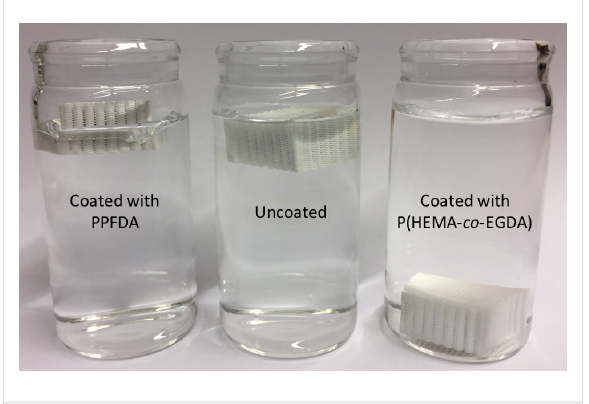
Figure 4: PLA lattices coated with PPFDA (left), uncoated (center), and coated with P(HEMA- co -EGDA) (right) in water.